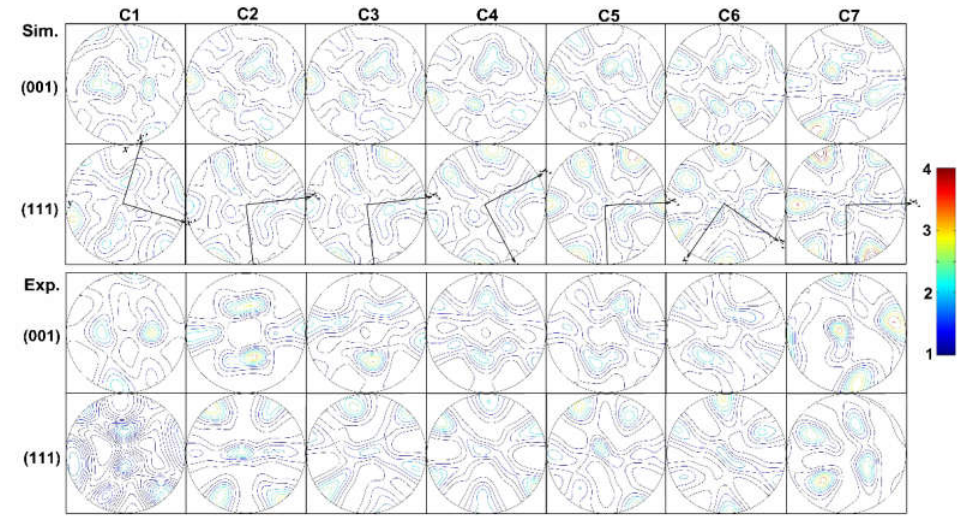
Figure 12. Experimental and Simulated {001} and {111} pole figures along the flow line